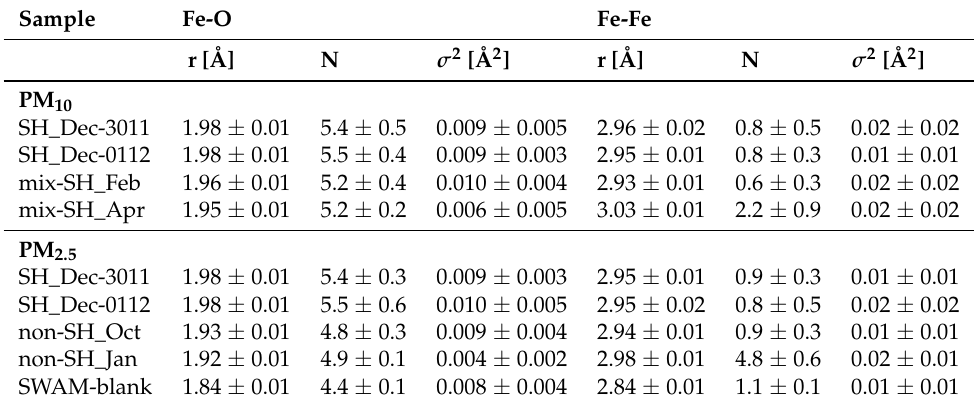
Table 3. EXAFS data analysis results. Bond distances (r), coordination numbers (N) and amplitudes ( σ 2 ) are obtained from the spectra fits.